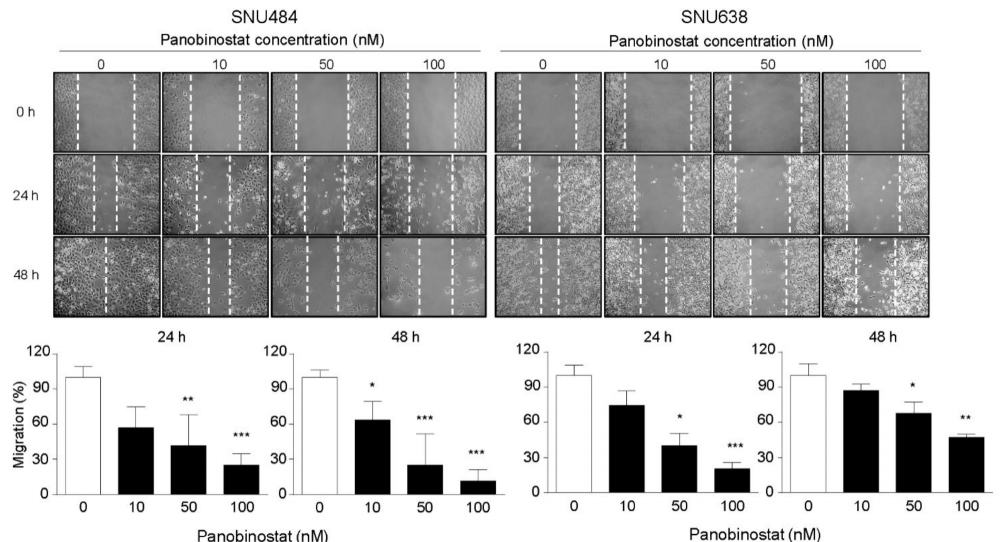
Figure 4. Panobinostat suppresses cell migration in gastric cancer cells. SNU484 and SNU638 cells were treated with panobinostat (0, 10, 50, and 100 nM), and migratory rates were detected by wound healing assays. Panobinostat significantly inhibited cell migration in a dose-dependent manner at 24 and 48 h. Data represent the mean ± SE of three independent experiments. * p < 0.05, ** p < 0.01, and *** p < 0.001 compared with the